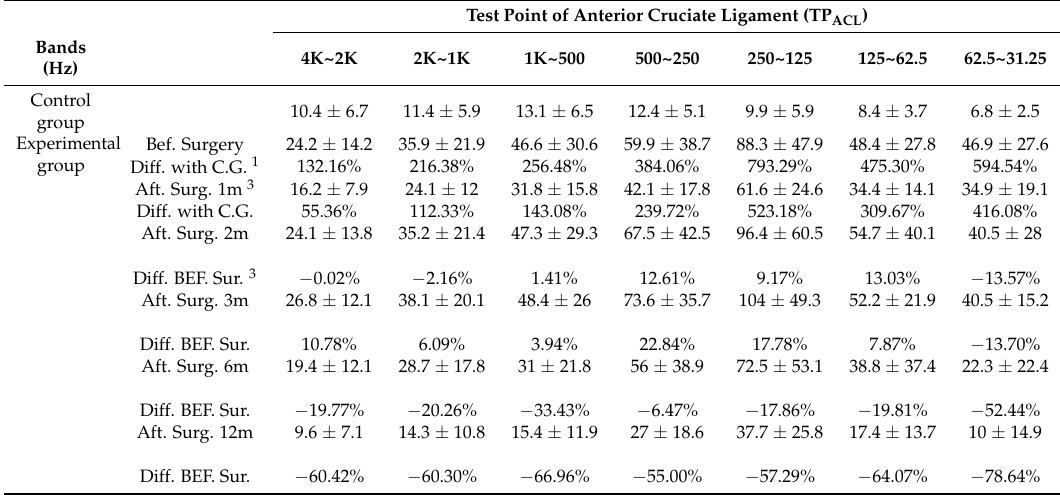
Test Point of Anterior Cruciate Ligament (TP ACL )